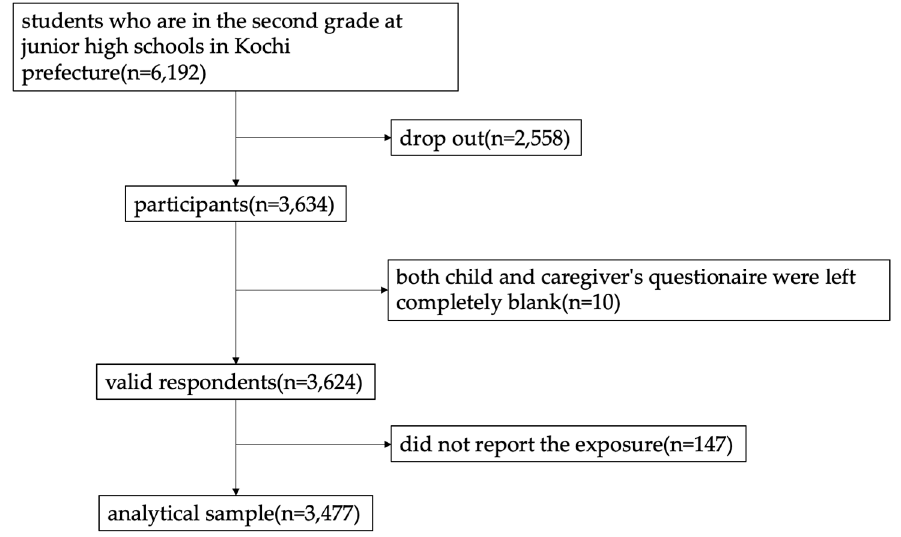
Figure 1. Requirement flow chart.